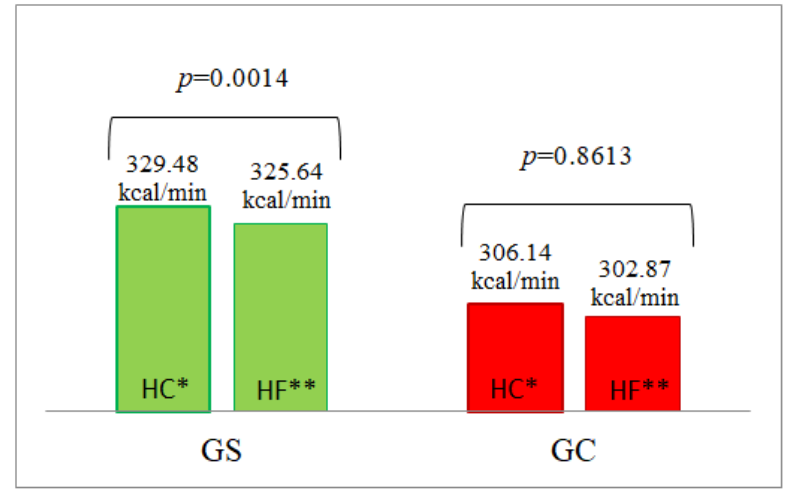
Figure 5. The AUC of energy expenditure in the G S and G C groups after HC and HF meals. The results are presented as the mean values. The results are presented as the mean values. * difference between the G S (obese/overweight) and G C (normal body weight) groups after HC meal (high-carbohydrate meal ( p = 0.6444)); ** difference between the G S and G C groups after HF meal (high-fat meal ( p = 0.3693)).